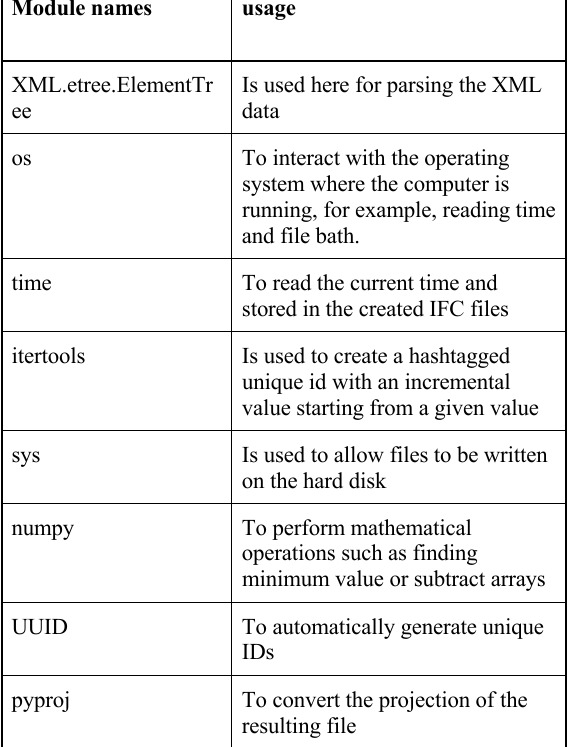
Table 2. Necessary modules for the Python program to run The function ‘CityGML2IFC (path,dst)’ is the main function